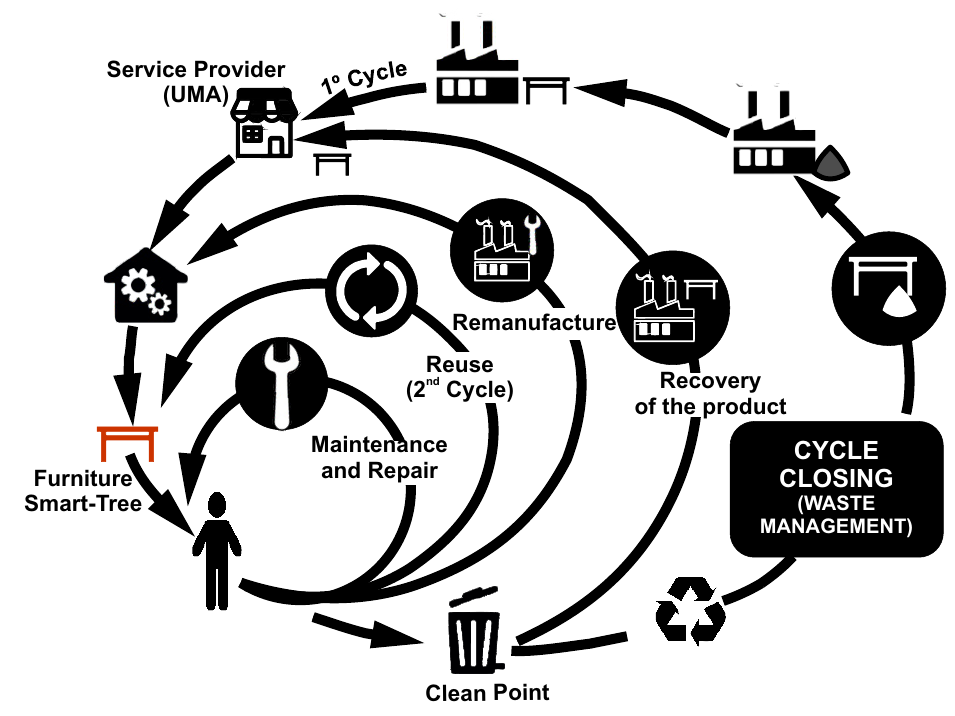
Figure 11. Smart-Tee Table LC Circularity